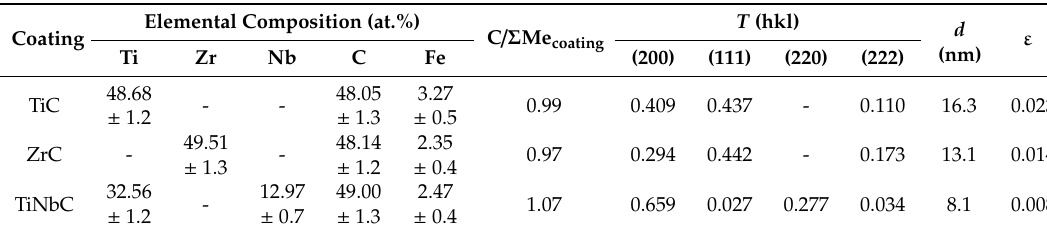
Table 2. Elemental composition measured by EDS, texture coe ffi cient T (hkl), crystallite size d , and strain ε determined by the Williamson–Hall plot method of the investigated